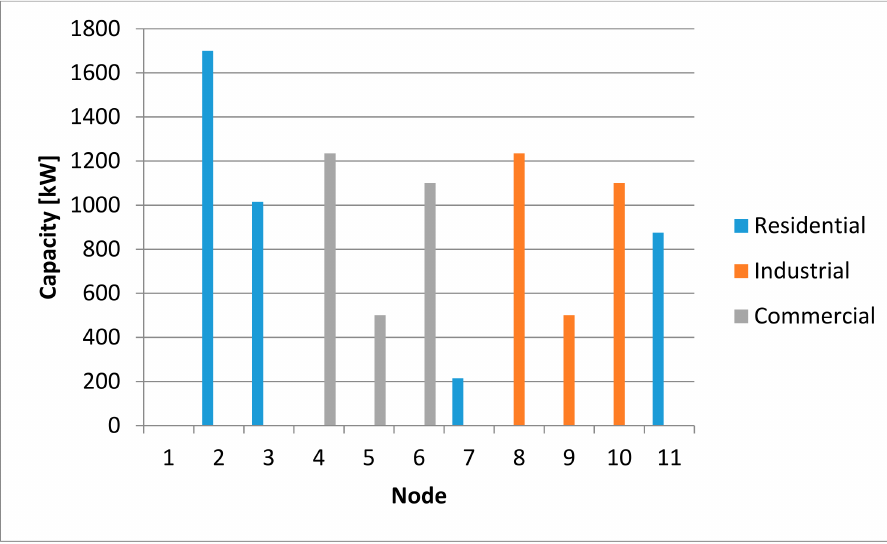
Figure A2. Capacity of